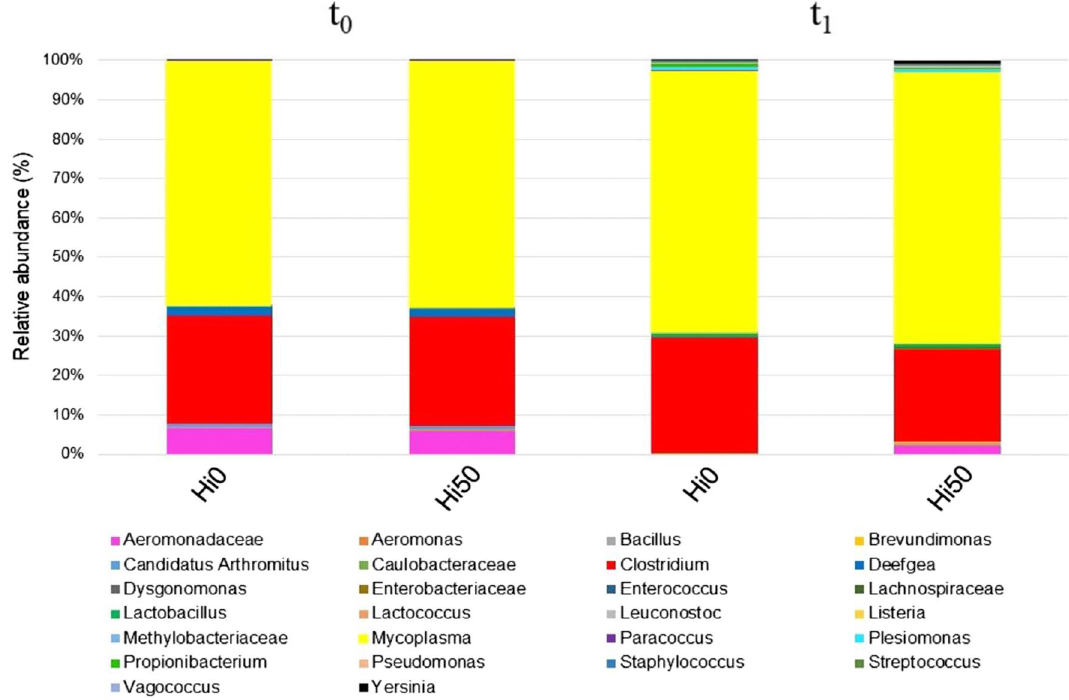
Figure 6. Relative abundances (%) of bacterial community in Siberian sturgeon gut samples at both t 0 and t 1 as identified by MiSeq Illumina. Sturgeon fed diets including 0 and 50 of BSF meal (Hi0 and Hi50, respectively).